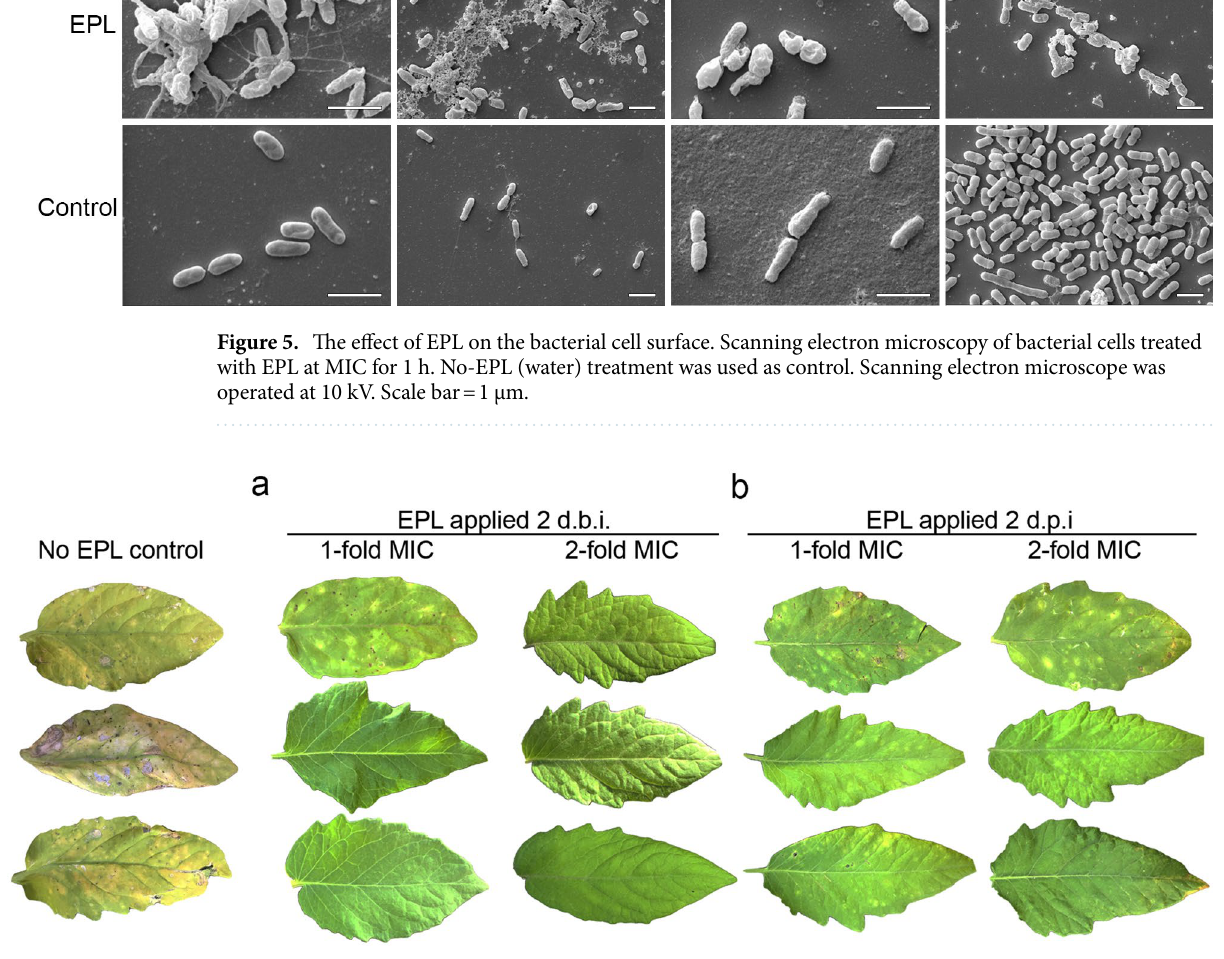
Figure 6. Enhanced protection against bacterial spot in tomatoes sprayed with EPL solution. Twelve Santa Cruz-Kada tomato plants were analyzed for each condition after 30 days of X. euvesicatoria inoculation . The figure shows representative leaves of three tomato plants treated with EPL (onefold MIC or twofold MIC) 2 days before inoculation ( a ), and tomato plants treated with EPL (onefold MIC or twofold MIC) 2 days post- inoculation ( b